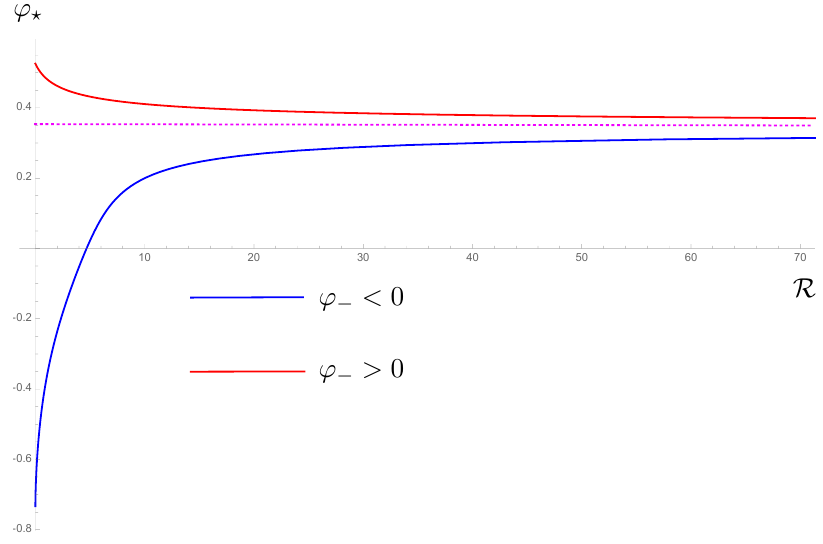
Figure 14 . Equilibrium brane position ’ ? vs. R for R > 0. Results are obtained for bulk potential (3.1), brane quantities (3.6) and parameter values (3.7). For R ! 1 both the red and blue branch asymptote to the value for ’ ? indicated by the dotted magenta